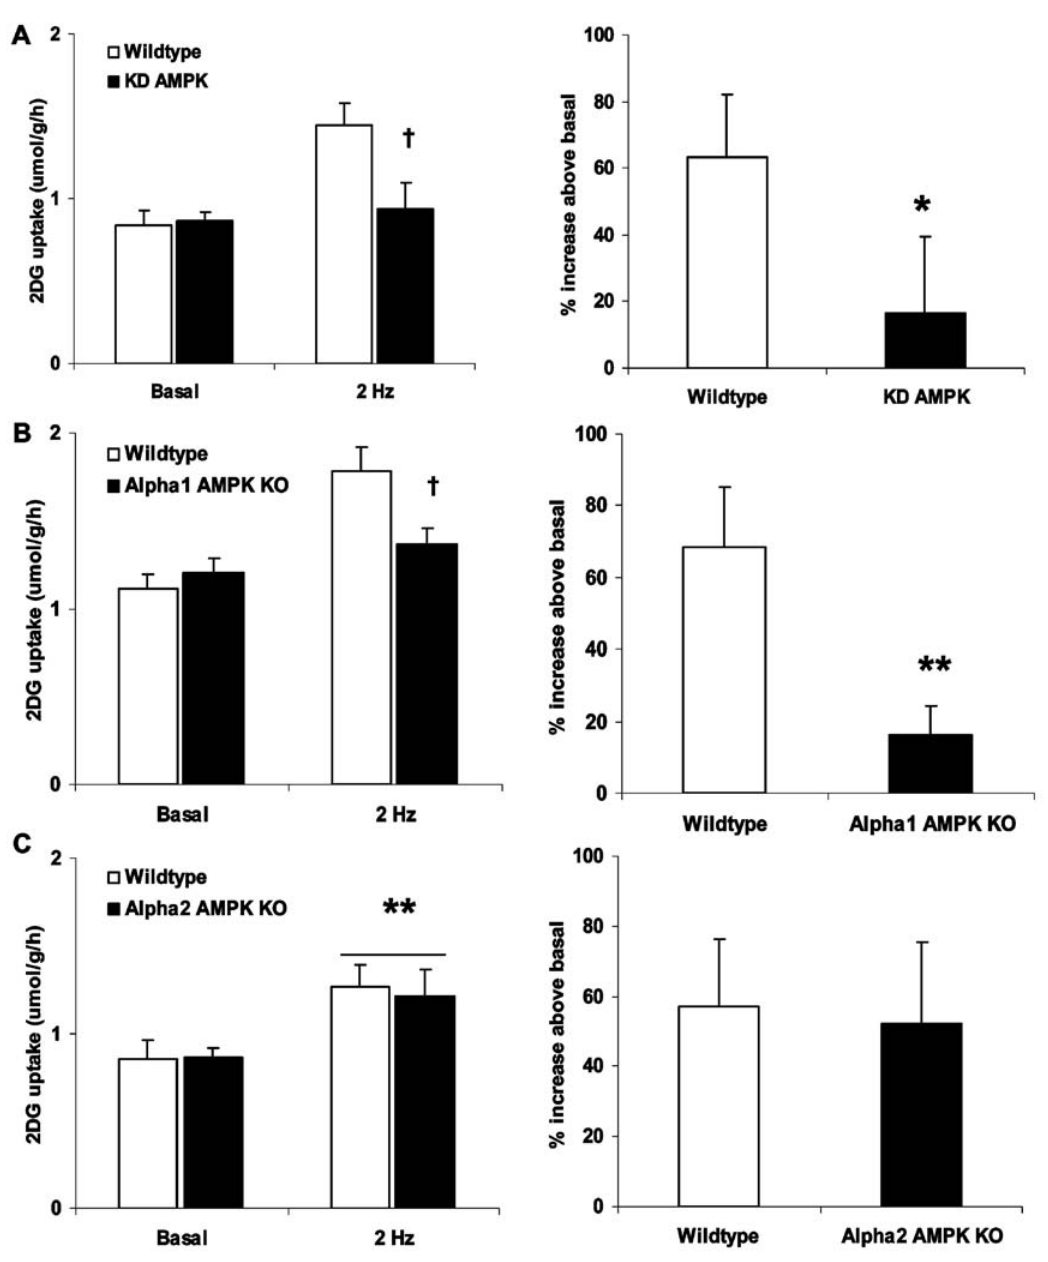
Figure 5. Twitch-contraction requires a 1 AMPK to stimulate glucose uptake. Twitch contraction (0.1 ms, 2 Hz, 2 min) stimulated 2- deoxyglucose in mouse soleus muscles from either A) wildtype vs. kinase-dead AMPK muscles (n=10–13) B) wildtype vs. a 1 AMPK KO muscles (n=16–17) C) wildtype vs. a 2 AMPK KO muscles (n=11–12). Absolute values are shown on the left and the corresponding percentage increase above basal for paired muscles is shown on the right. */** p , 0.05/0.01 vs. wildtype or basal, { genotype x contraction p , 0.05.